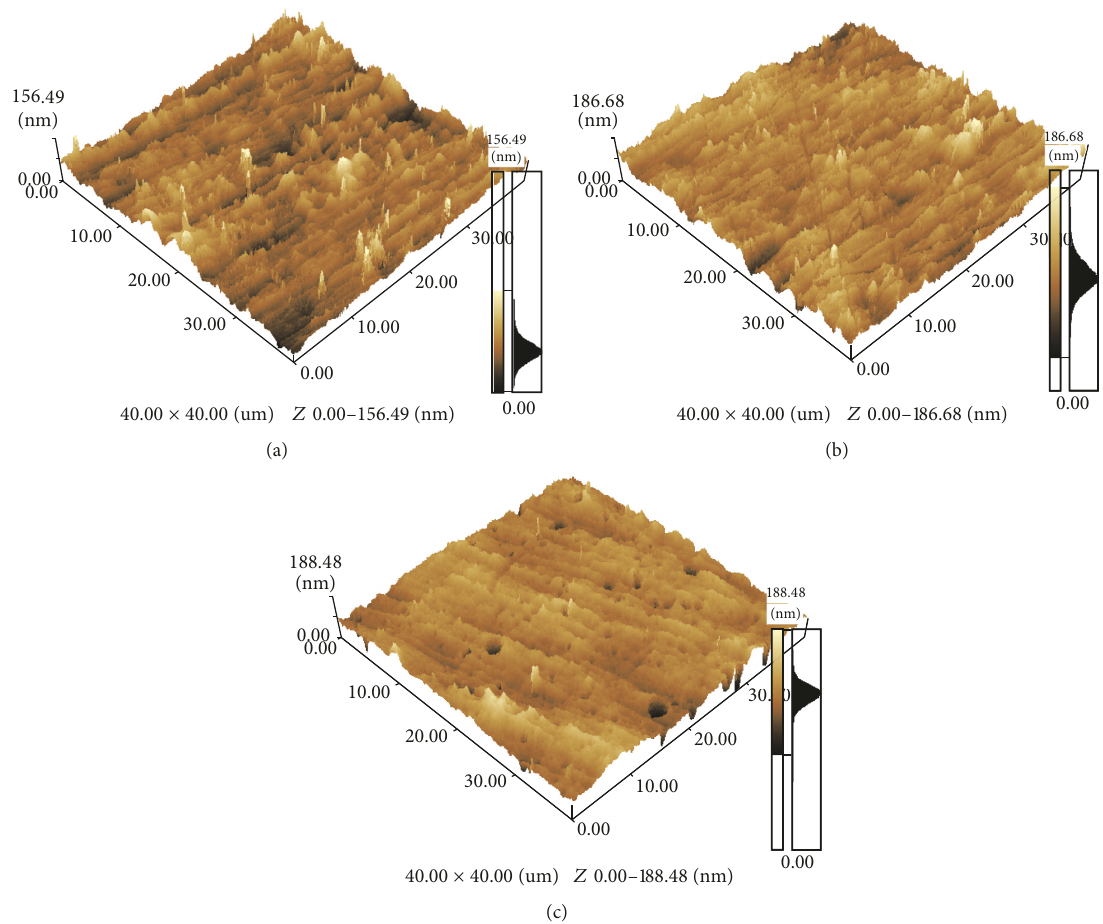
Figure 4: AFM images in surface morphology of PI films before and after surface modification with 1.0 g/L TiO 2 dispersed solution for 30 min, UV power: (a) 0W, (b) 100W, and (c) 300 W.